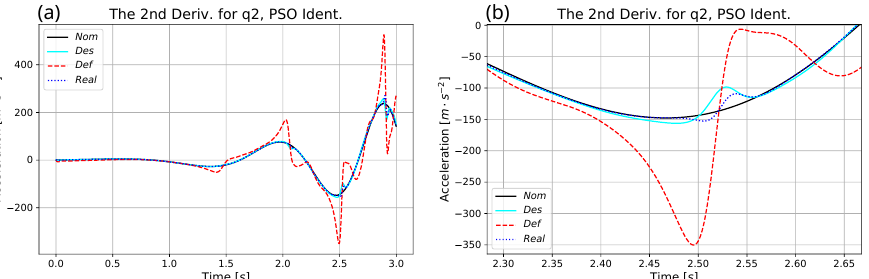
Figure 21. Second time derivatives for q 2 ( a ) and the zoomed-in excerpt ( b ) during the parameter identification process.